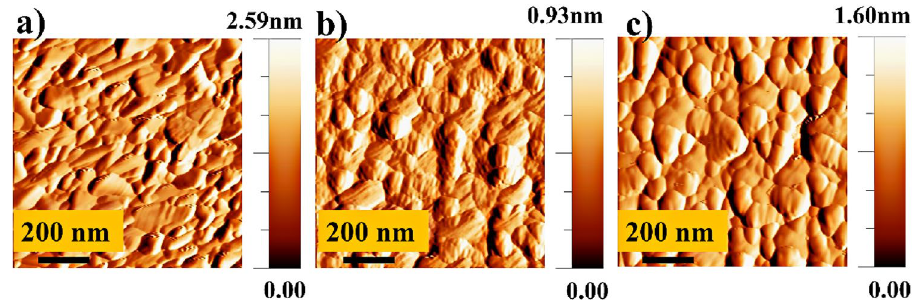
Figure 2. AFM images of various substrates of ( a ) FTO, ( b ) FTO/NiO x , and ( c ) FTO/MoO 3 .